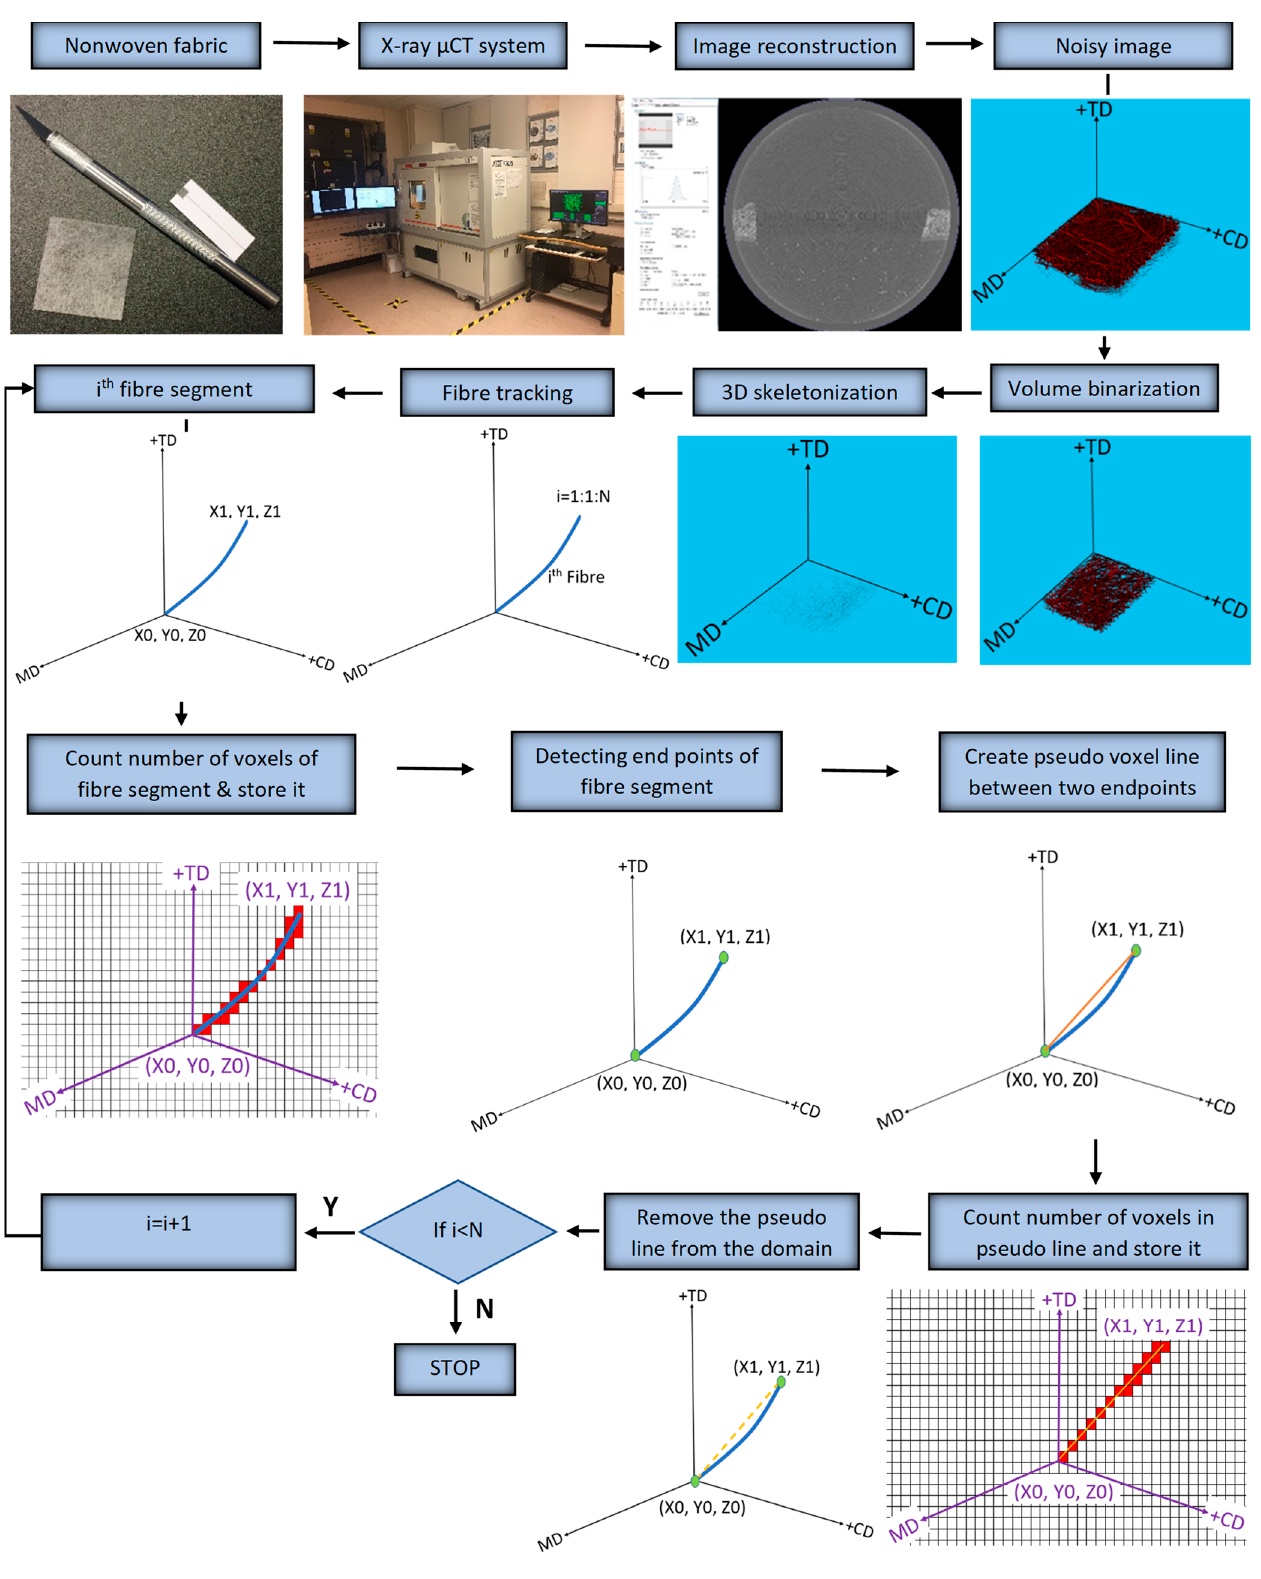
Figure 2. Process flow chart: i represents the fibre number, and i = 1,2, 3, . . . N, where n indicates the total number of fibre segments in the nonwoven model.